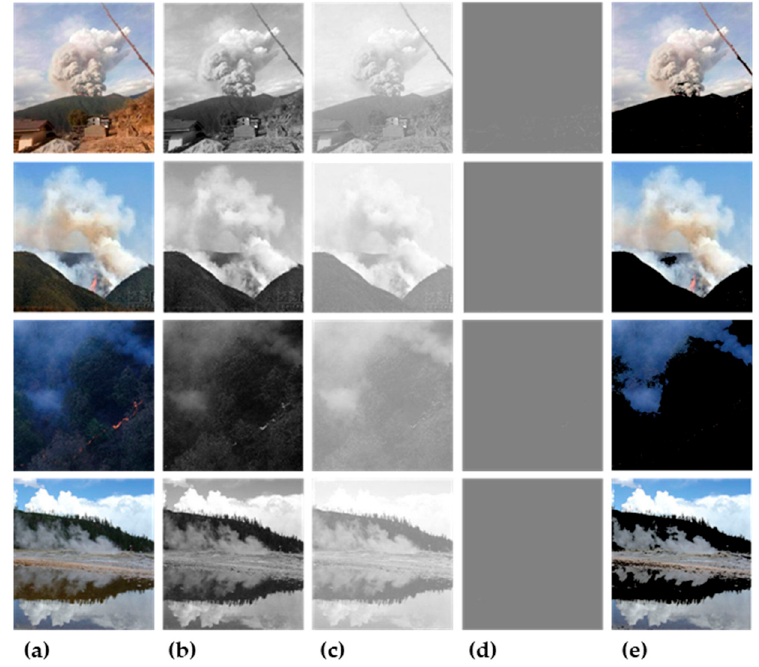
Figure 1. Segmentation results in the YUV color space. ( a ) RGB image, ( b ) Y component, ( c ) U component, ( d ) V component, and ( e ) candidate smoke region.